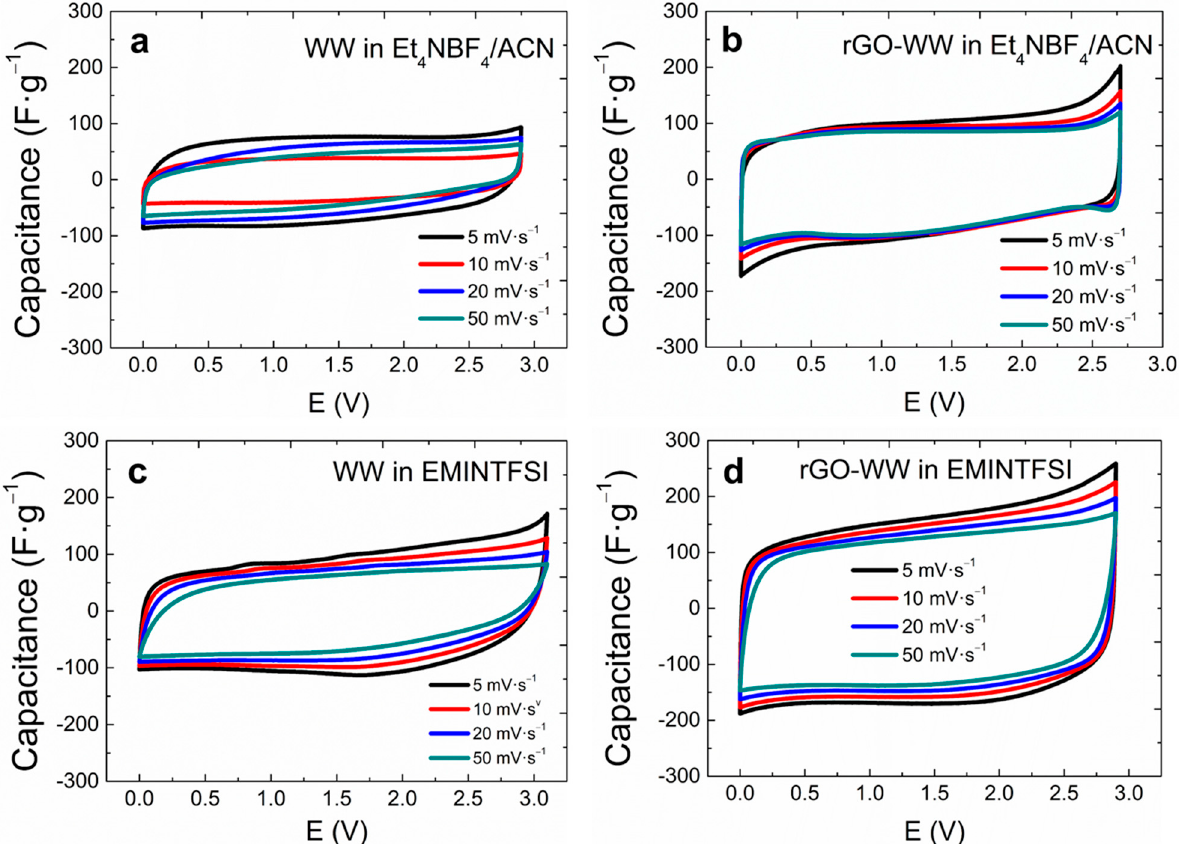
Figure 3. Cyclic voltammetry curves registered for supercapacitors assembled using WW in 1 M Et 4 NBF 4 ( a ), and EMINTFSI ( c ); and corresponding measurements for rGO-WW ( b , d ). Galvanostatic charge/discharge curves at different current densities registered for these samples at 0.5 and 5 A · g − 1 are depicted in Figure 4. It can be observed that all samples show linear voltage increase/decrease during charge and discharge with the typical triangular shape of capacitive-type charge storage mechanisms. At the low current density of 0.5 A · g − 1 , both ACs show very small ohmic drop (Figure 4a,c), which are progressively enlarged as the current rate is increased to 5 A · g − 1 (Figure 4b,d). It is worth highlighting that this behavior is more pronounced for the EDLCs measured in the ionic liquid (EMINTFSI) due to its lower ionic conductivity and its higher viscosity compared to the organic electrolyte (Et 4 NBF 4 ) (see Table 2). The sample without graphene oxide exhibits a larger ohmic drop compared to the graphene-containing one, which could be associated to its lower electronic conductivity.